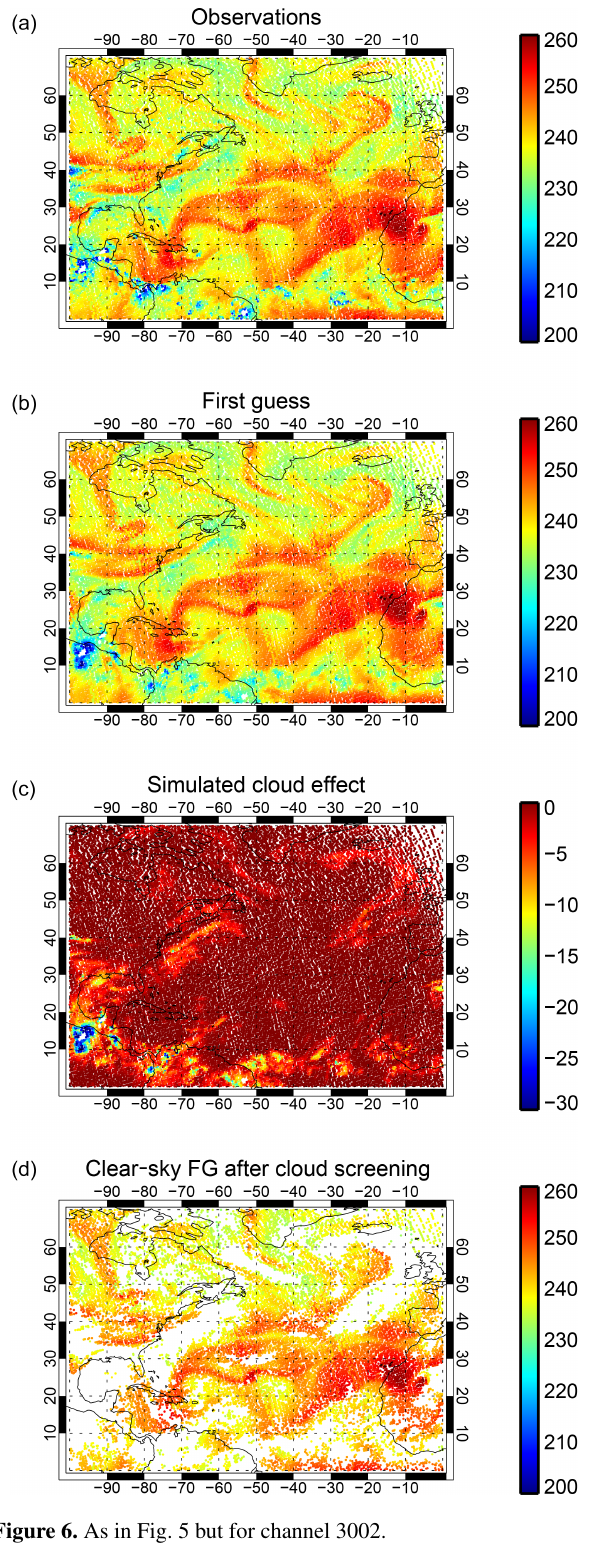
Figure 6. As in Fig. 5 but for channel